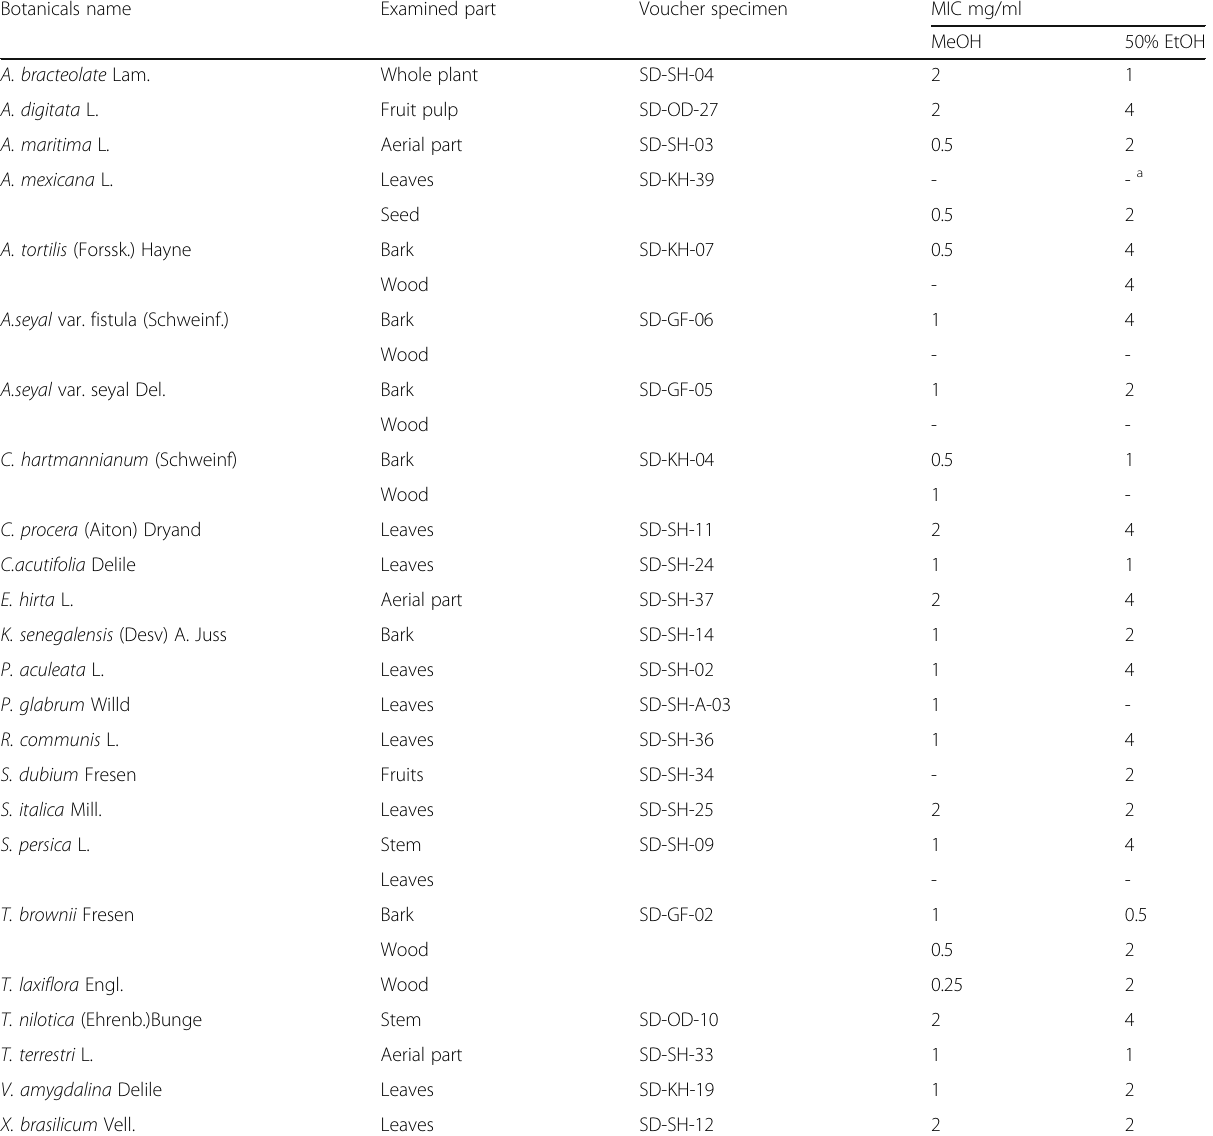
Table 3 Minimum inhibitory concentration (MIC) activities of selected Sudanese medicinal plants against P. gingivalis Botanicals